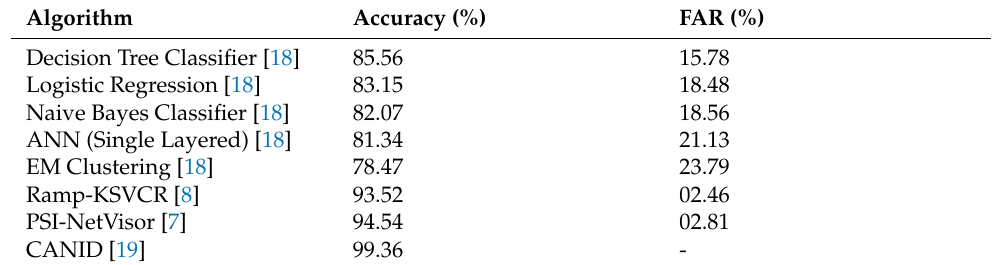
Table 6. Comparison of our proposed model with the models proposed in the literature.